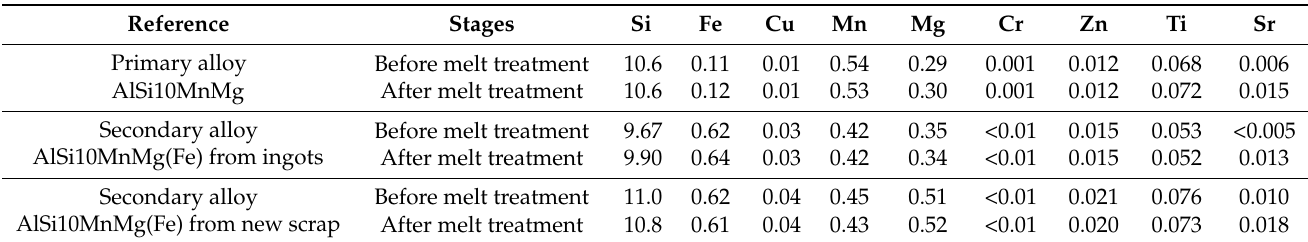
Table 1. Chemical compositions of the different aluminium samples tested in this study before and after the melt treatment (wt.%).